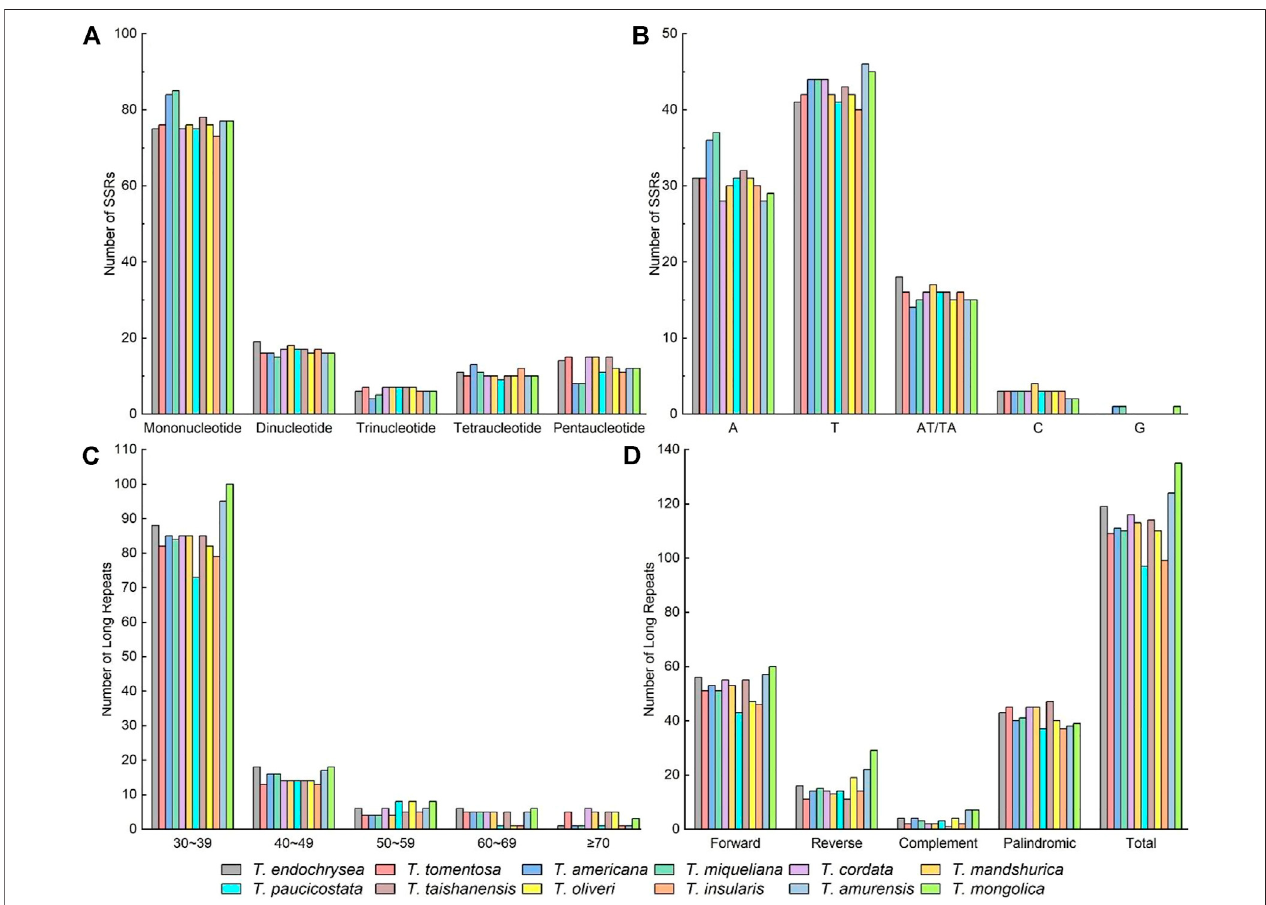
FIGURE 2 | Distribution of SSRs and dispersed repeats in the chloroplast genomes of Tilia. (A) Numbers of different SSR types detected in the cp genomes; (B) NumbersofdifferentSSRclasstypes; (C) NumbersofthefourdispersedrepeattypesinTilia; (D) Numbersofdispersedrepeattypeshavingagivenlengthinterval(30to 39, 40 to 49, 50 to 59, 60 to 69 and ≥